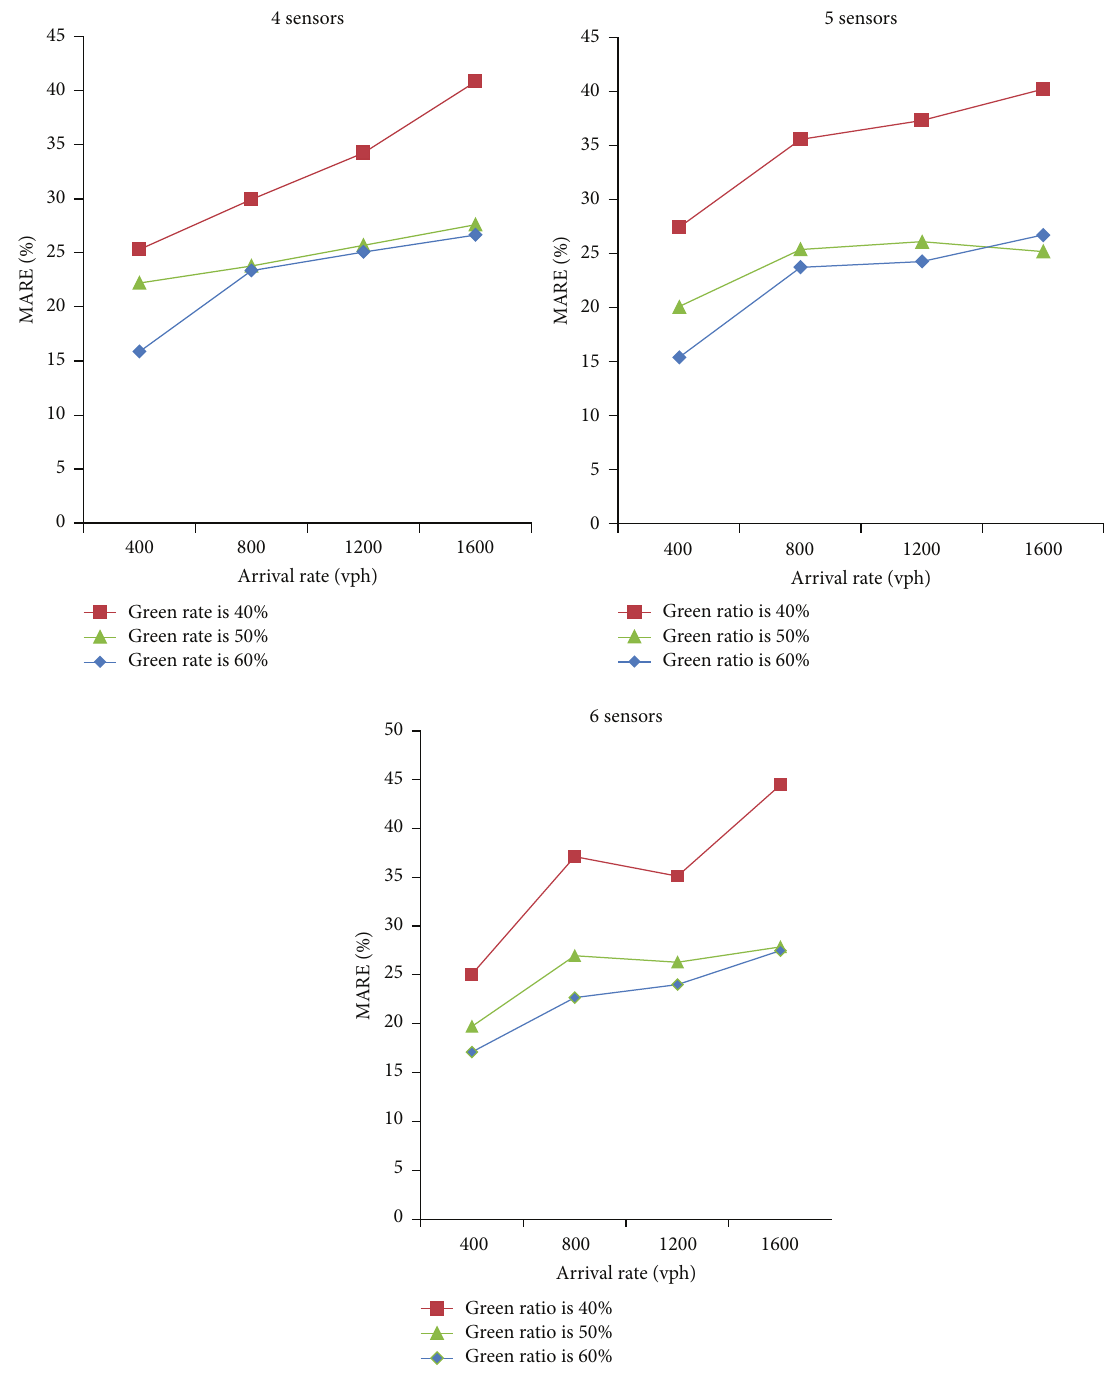
Figure 8: Comparison among different green